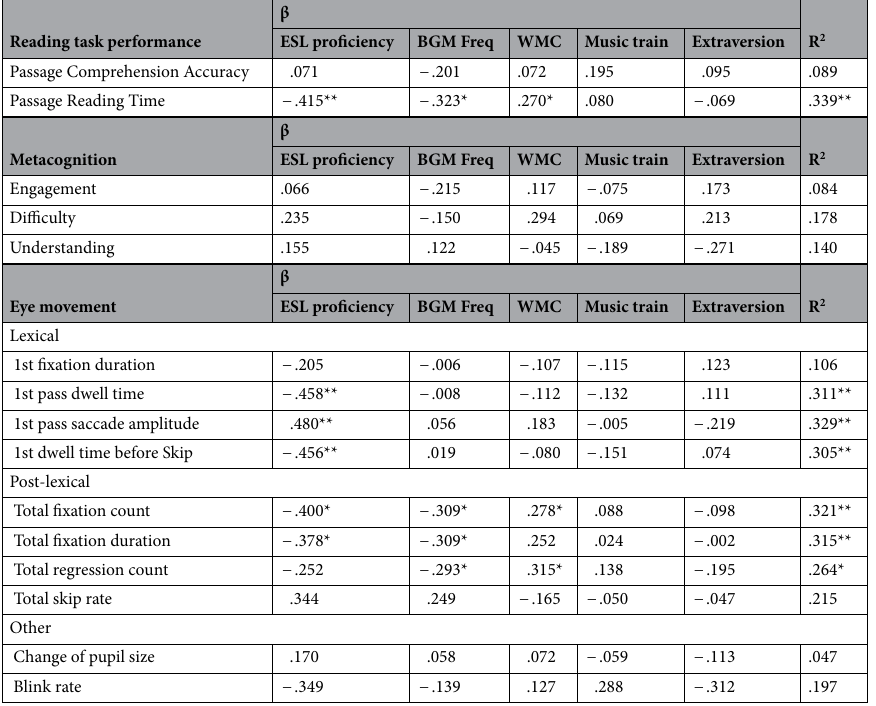
Table 6. Classical linear regression models of BGM group (Experimental). * p < .05; ** p < .01. Note. ESL Proficiency: ESL learners’ English proficiency measured by LexTale test, BGM Freq.: BGM listening frequency in daily life, WMC: Working memory capacity measured by N-back task, Music Train: Training on music, Extraversion: Extraversion measured by TIPI subscale.